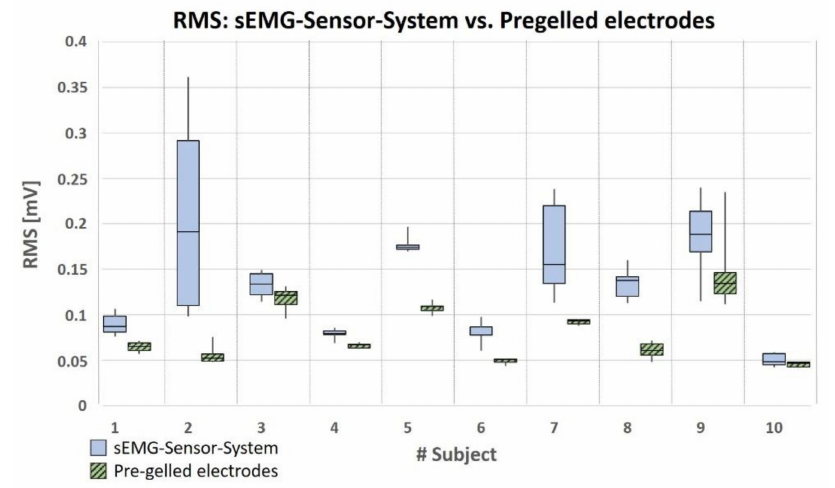
Figure 6. RMS values in the phases of muscular activation resulting from the sEMG signal of the first relevant channel of the sEMG sensor system and a sEMG signal derived with the commercial sEMG system (pre-gelled electrodes), all recorded according to the SENIAM recommendations. The values are based on five independent trials each of five repetitive flexion / extension movements of the elbow.